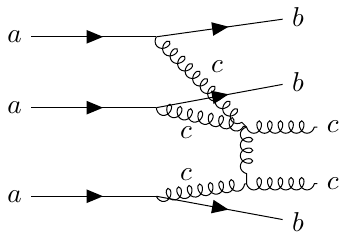
Figure 13 . 3-to-2 scattering between emitted vector bosons which is expected to deplete the boson abundance and to possibly provide an IR cut-off µ for the